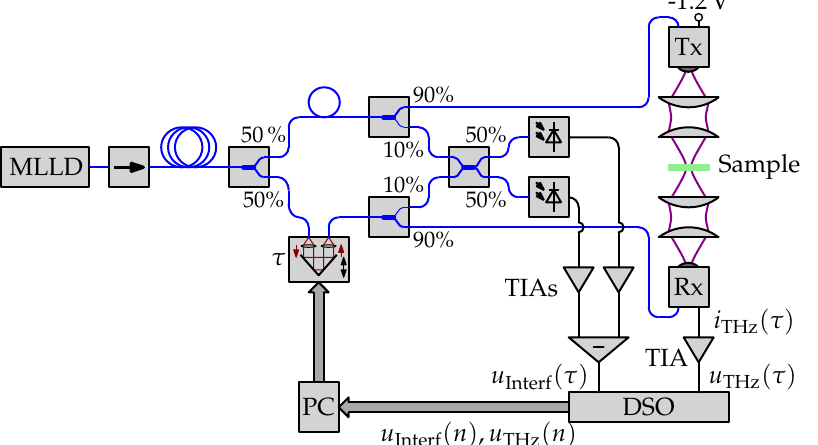
Figure 4. Block diagram of the measurement setup. Blue lines indicate PM fibers. Black lines indicate electrical connections. Bold arrows indicate electrical buses. The terahertz beam path is schematically indicated by purple